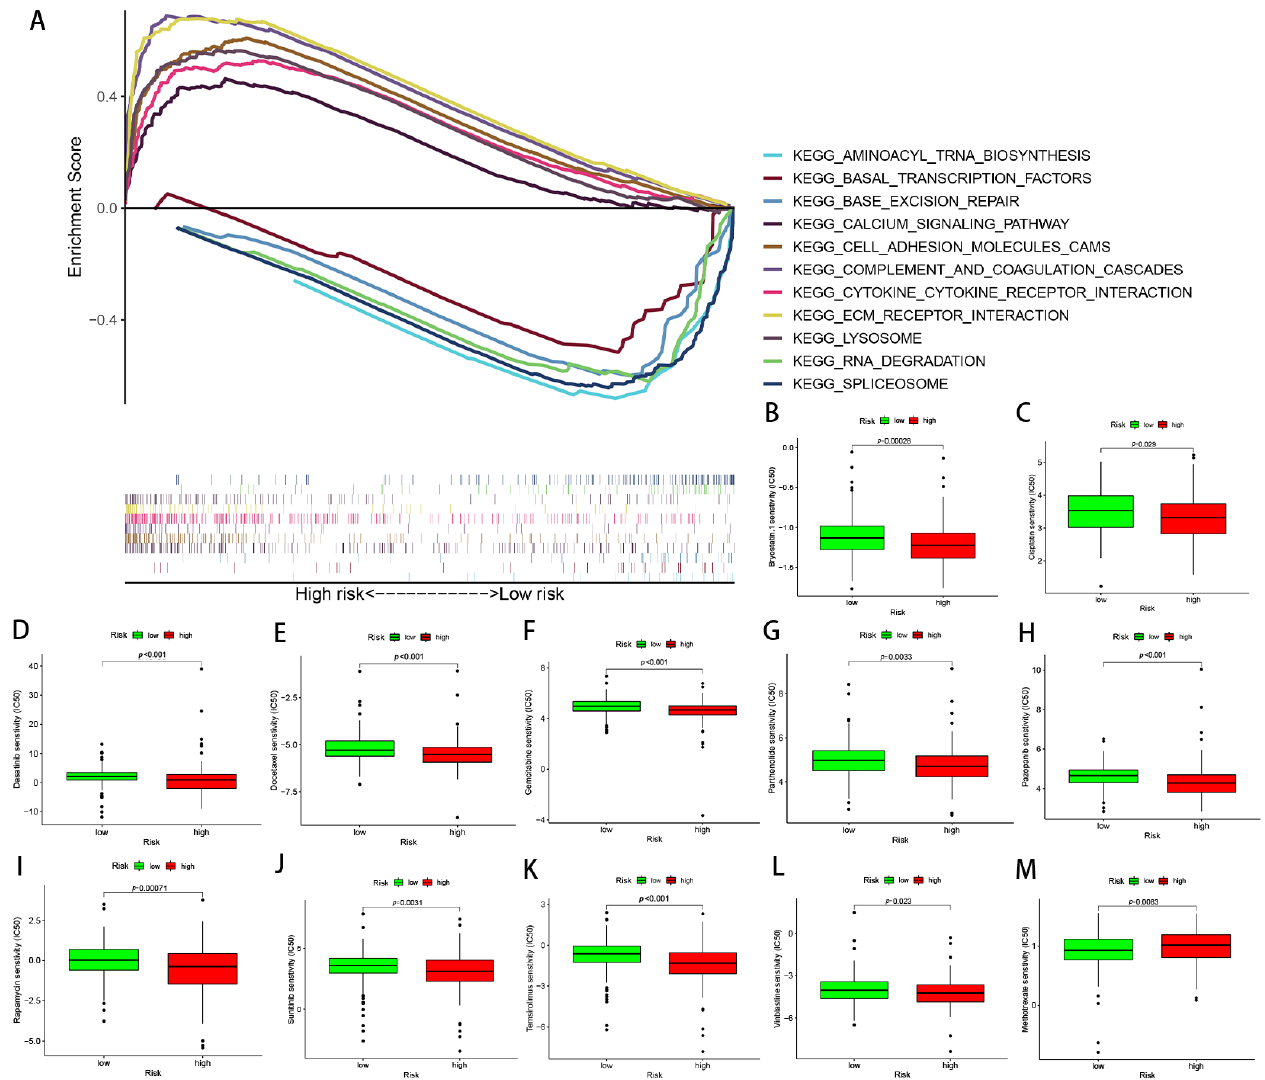
Figure 10. Functional enrichment and drug susceptibility analysis of the predicted signatures. ( A ) The function of pathways associated with the predicted signatures, as determined via GAEA. ( B – M ) The IC50 of Bryostatin.1, Cisplatin, Dasatinib, Docetaxel, Gemcitabine, Parthenolide, Pazopanib, Rapamycin, Sunitinib, Temsirolimus, Vinblastine, and Mitomycin C in the high- and low-risk groups.